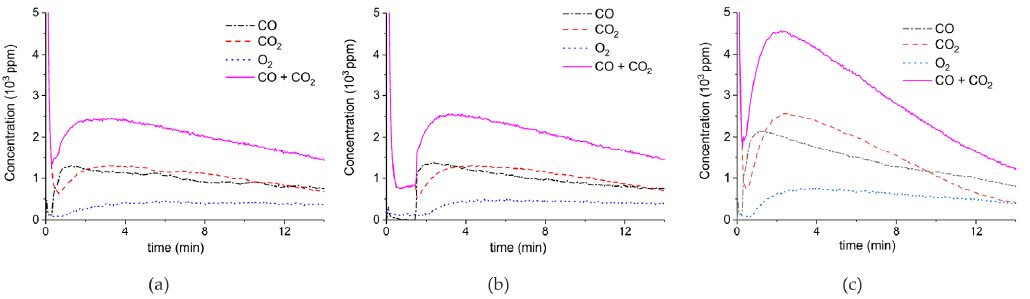
Figure 4. Concentration of the products of CaCO3 decomposition (sample C) as function of time at 630 °C in pure argon, flow rate of 30 mL/min, plasma power is 2.1 W ( a,b ) and 4.4 W ( c ). Plasma is turned on at the beginning of decomposition (a,c) or after 1.5 min (b).